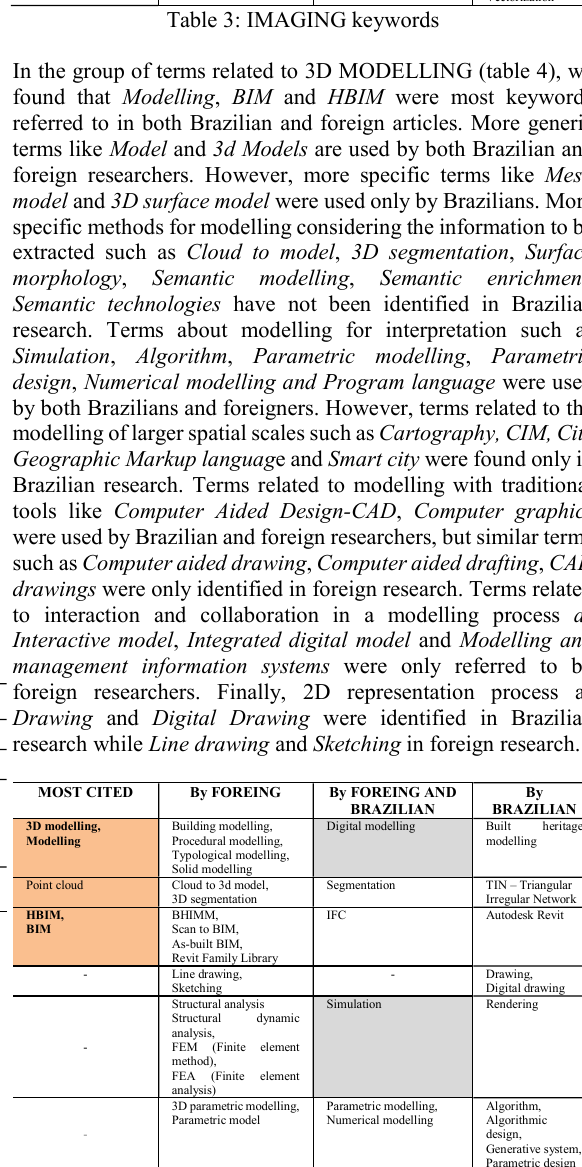
Algorithm, Algorithmic